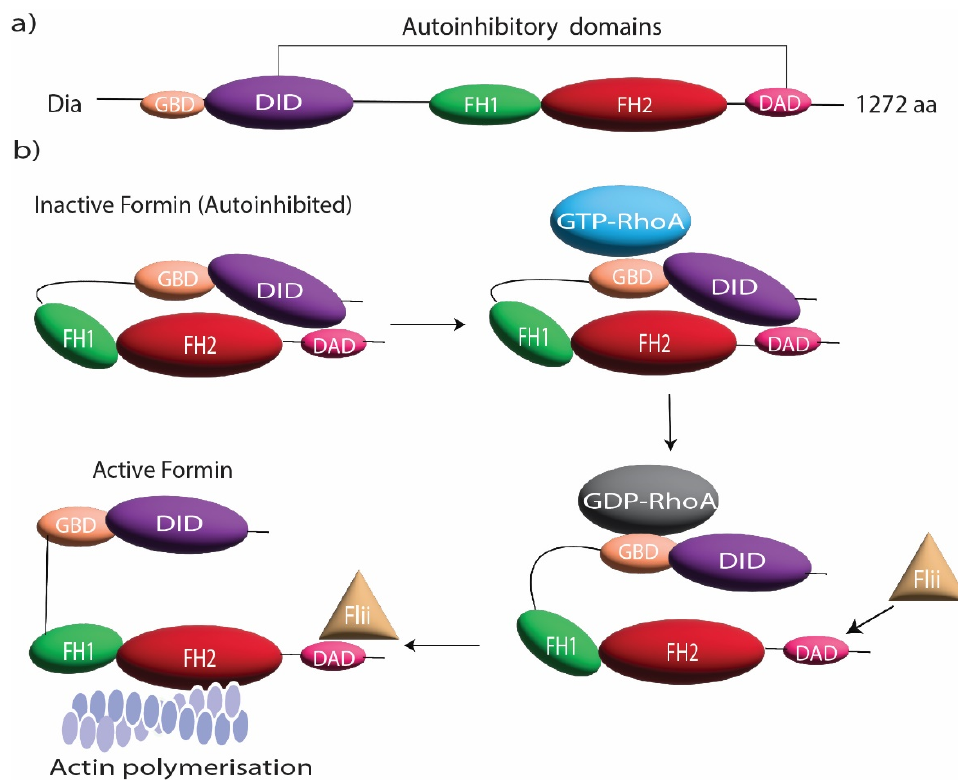
Figure 1. Formin structure and regulation. ( a ) Domain organization of DRFs including GBD, DID, FH1, FH2, and DAD. ( b ) The domain organization during the autoinhibitory regulation of DRFs and its release by RhoGTPase and Flightless I (Flii).